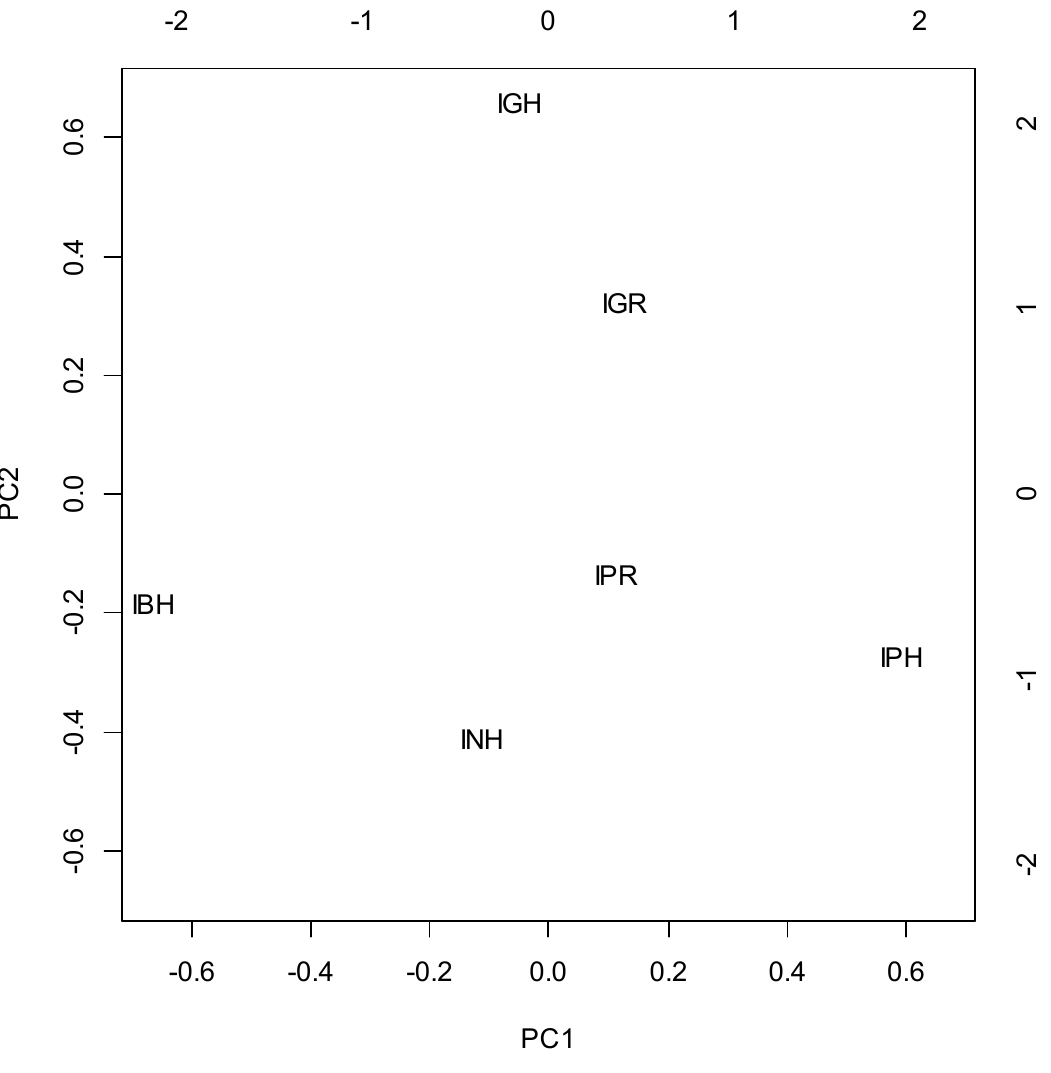
Figure 2 . Scores of scaled principal component analysis: a comparison of the correlations between constituents among investigated materials. IBH, I. balsamina herb; IGH, I. glandulifera herb; IGR, I. glandulifera roots; INH, I. noli-tangere herb; IPH, I. parviflora herb; IPR, I. parviflora roots.